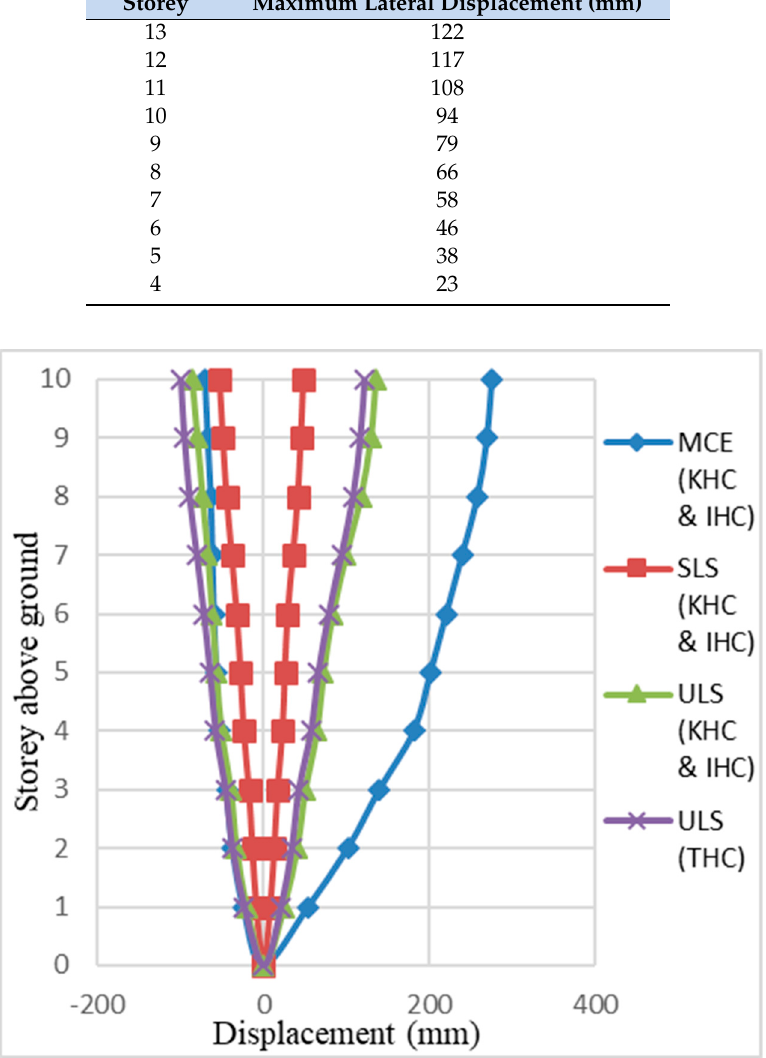
Figure 8. Displacement envelope for whole building with slab.